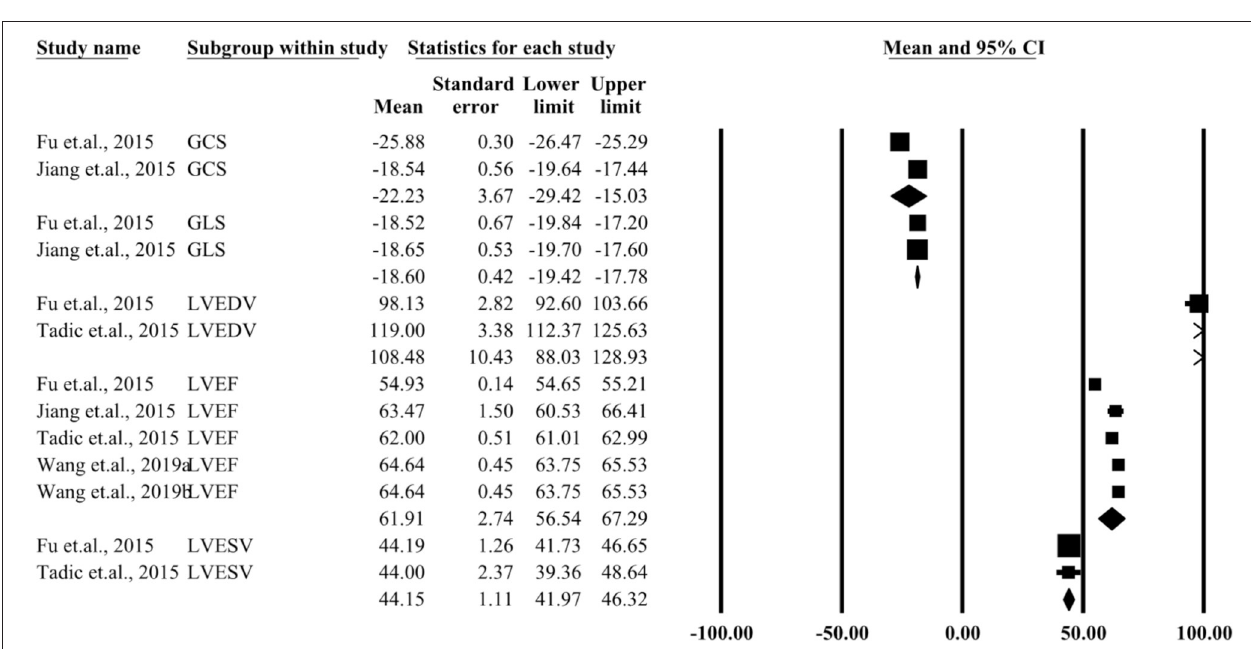
FIGURE 5 | Summary of three-dimensional echocardiographic parameters for left ventricular case group.